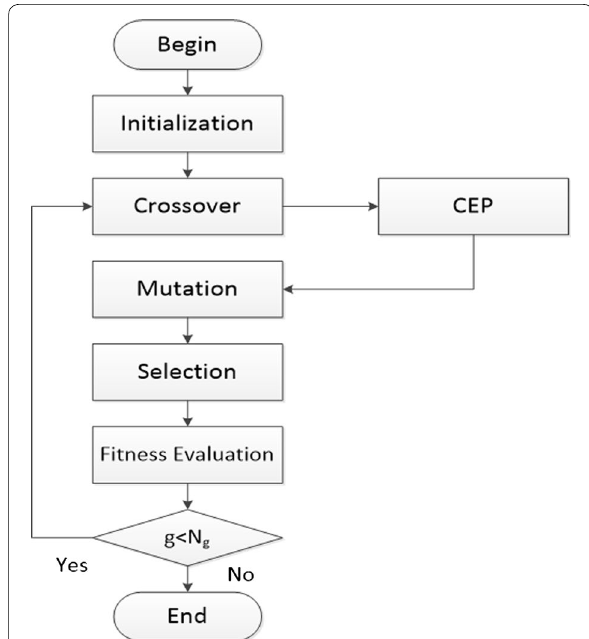
Fig. 2 Block diagram of CEPGA. The basic process of CEPGA is showed in the figure. CEP was applied after crossover so that the genes of the new population are